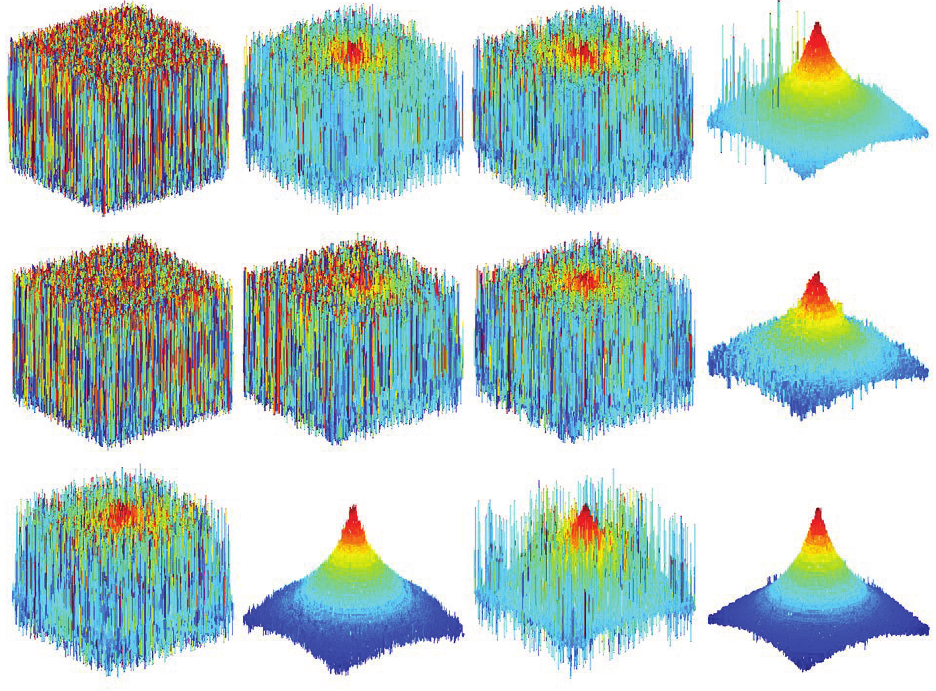
Figure 10. Depth maps: Gaussian noise with zero mean and a variance of 0.01 (first row), salt and pepper noise with a variance of 0.01 (second row), speckle noise with a variance pf 0.01 (bottom), ML (first column), GLV (second column), TEN (third column) and the proposed method (last column).